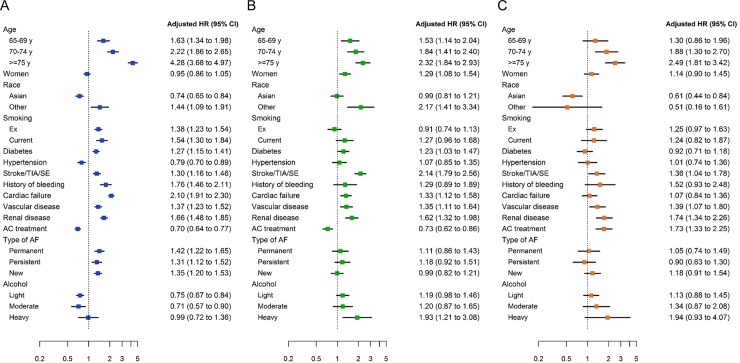
Adjusted hazard ratios for 2-year outcomes according to baseline characteristics and anticoagulant treatment: (A) all-cause mortality; (B) stroke/systemic embolism; (C) major bleeding. ‘Anticoagulant treatment’ includes both vitamin K antagonists and non-vitamin K antagonist oral anticoagulants. For race, ‘Asian’ includes Asian (not Chinese) and Chinese, and ‘other’ includes Afro-Caribbean, mixed/other, and unwilling to declare/not recorded. Reference groups, from top: <65 years, men, Caucasian/Hispanic/Latino, never smoker, no history of disease (for diabetes, hypertension, stroke/TIA/SE, history of bleeding, cardiac failure, vascular disease, and renal disease), no AC treatment, paroxysmal AF, alcohol abstinence. Hazard ratios were adjusted for all variables in the model. AC, anticoagulant; AF, atrial fibrillation; CI, confidence interval; HR, hazard ratio; SE, systemic embolism; TIA, transient ischaemic attack.